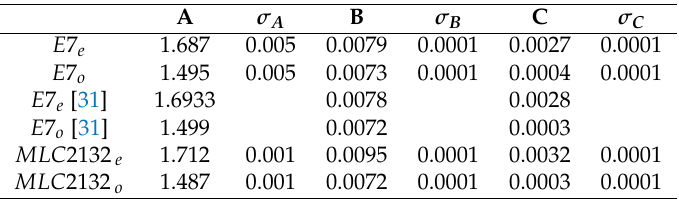
Figure 2. ( a , b ) E 7 measured and fitted spectral phase ( ϕ FTSI o , e ( λ ) , with the linear group delay term subtracted) for two different wavelength ranges. On both sub-plots are displayed the measurement for the extraordinary (black) and ordinary (grey) axes and the fit (following Equations (7) and (8), see text) for the extraordinary (orange) and ordinary (green) axes. The top insets display the overall phase ϕ o , e ( λ ) (extraordinary (black) and ordinary (grey)). ( c , d ) MLC 2132 measured and fitted spectral phase ( ϕ FTSI o , e ( λ ) , with the linear group delay term subtracted) for two different wavelength ranges. On both sub-plots are displayed the measurement for the extraordinary (black) and ordinary (grey) axes and the fit (see text) for the extraordinary (orange) and ordinary (green) axes. The top insets display the overall phase ϕ o , e ( λ ) (extraordinary (black) and ordinary (grey)). Table 2. E 7 and MLC 2132 extended Cauchy coefficients, after fitting the experimental data, for both LC axes. σ is the standard deviation of the fitted parameters. The data are acquired at a lab temperature of 20 ◦ C. Parameters values from [31] are shown for